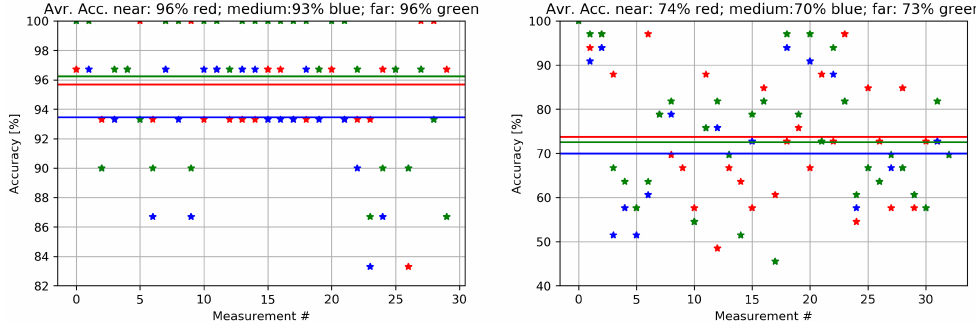
Figure 7. Overall accuracy for indoor ( left ) and outdoor ( right ) real scenario. The red, blue, and green dots denote the single measurement accuracy for near, medium, and far paired devices, respectively, while the red, blue, and green lines illustrate the average accuracy for near, medium, and far paired devices,